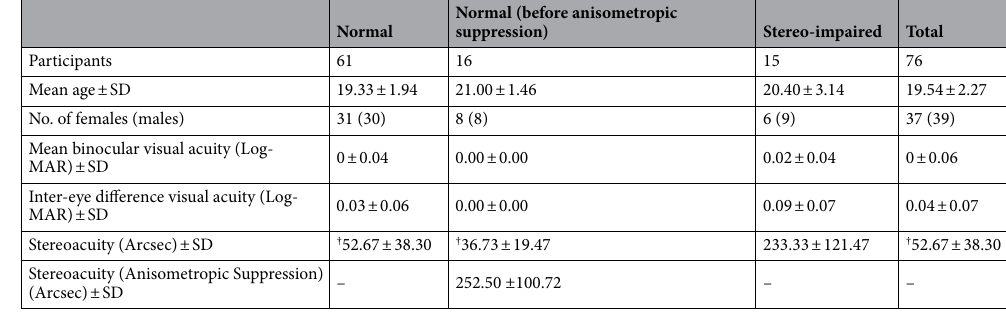
Table 1. Characteristics of observers. † Mean stereoacuity and standard deviation calculated in participants who could perceive global stereopsis. SD standard